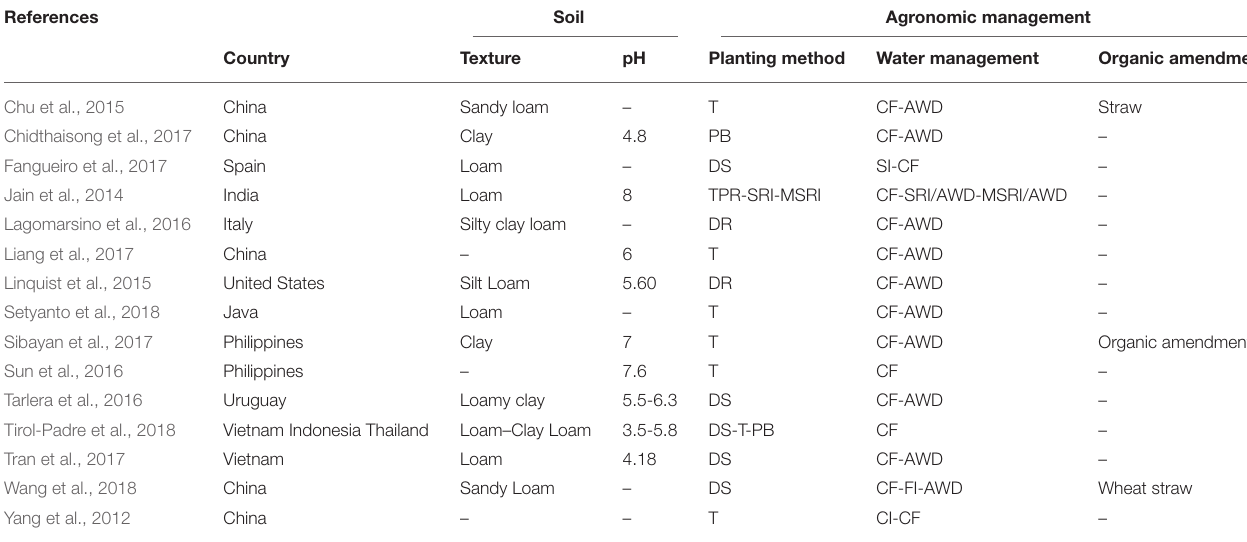
Studies selected from the dataset in Step Three: Normalization and Selection of Literature-Derived Reference GHGI and WP. T, Transplanted; DS, Direct seeding; DR, Dry-seeding; PB, pre- germinated broadcasting method; TPR, conventional puddled transplanted; SRI, Conventional System of Rice Intensification; MSRI, Modified System of Rice Intensification; CF, Continuous Flooding; AWD, Alternate Wetting and Drying; FI, Furrow Irrigation; CI, Controlled Irrigation; SI, sprinkler